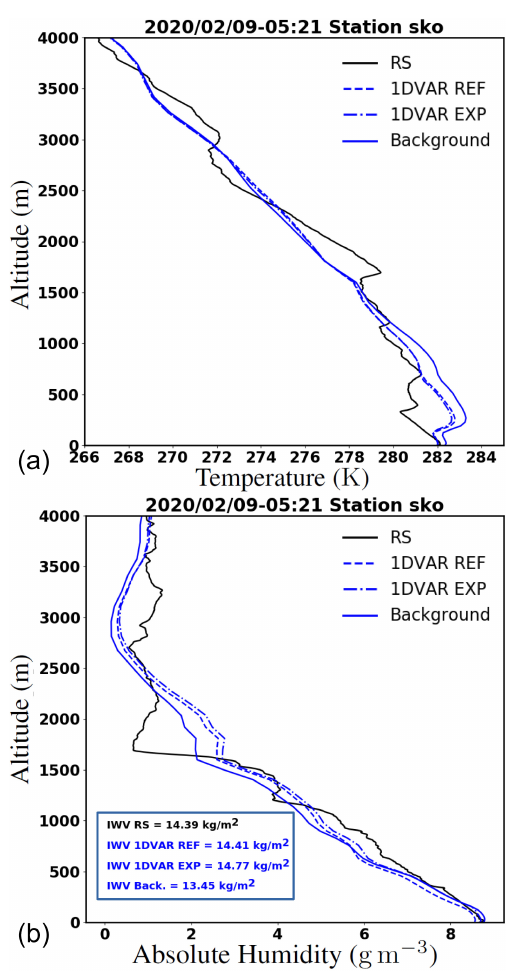
Figure 7. Vertical profiles of absolute temperature T ( a , in K) and absolute humidity ρ v ( b , in gm − 3 ) for 9 February 2020 and show- ing the RS launched at 05:21UTC (solid black), the AROME back- ground valid at 06:00UTC (solid blue) and the 1D-Var retrievals at 06:00UTC obtained with REF (dashed blue) and EXP (dot–dashed blue). Integrated water vapour (IWV) retrievals are also compared to the RS IWV (in the blue box in the bottom